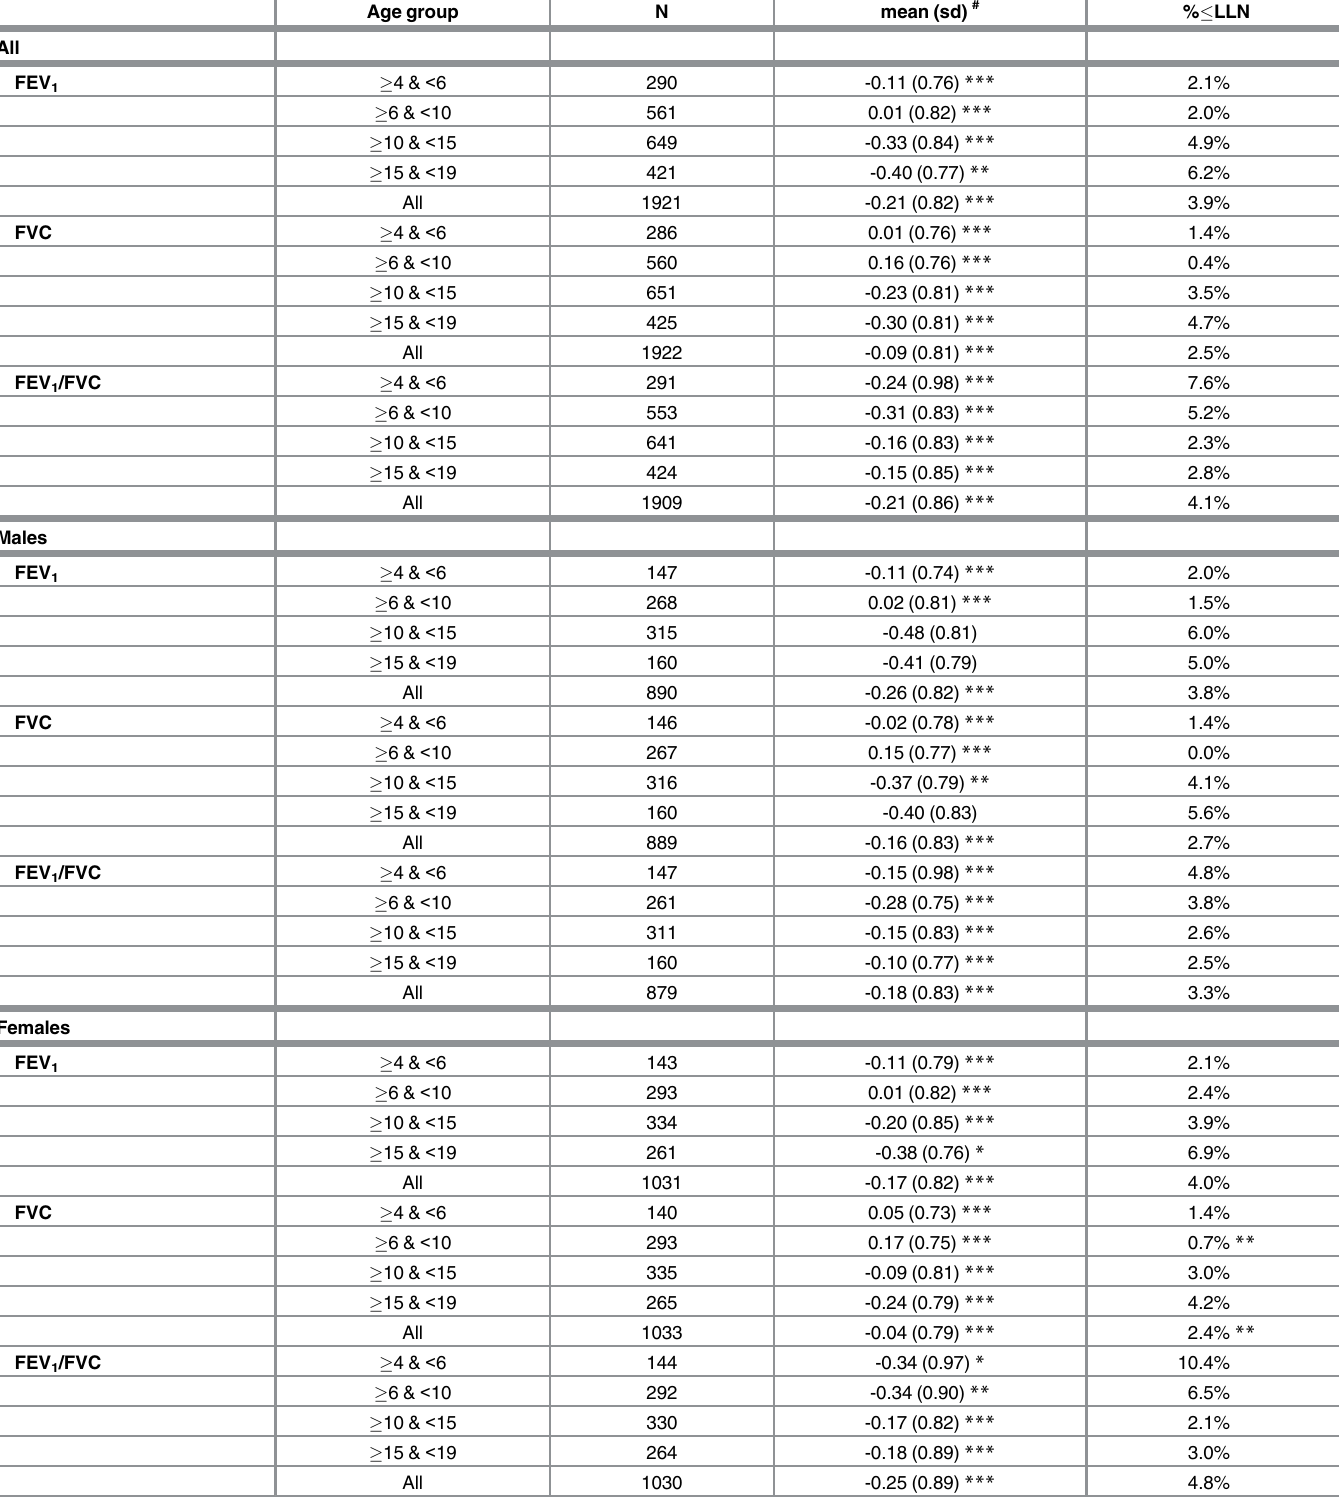
Table 3. LUNOKID: GLI-based z-scores of all and of all male and female healthy children/adolescents grouped by age. Age group N mean (sd) # % (cid:5)